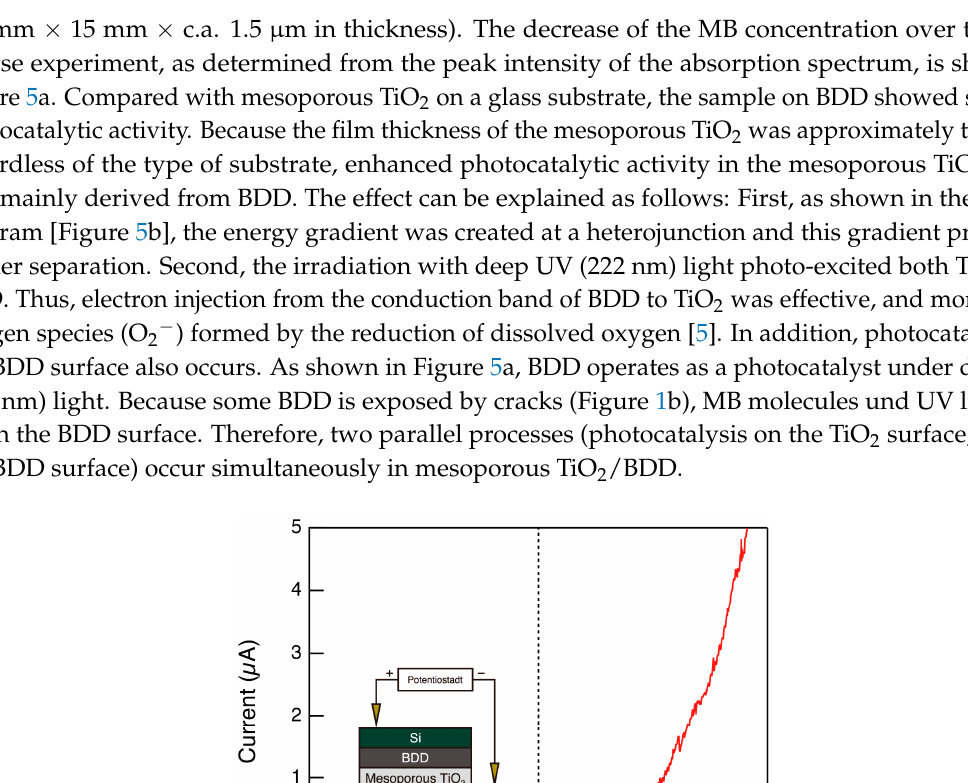
Figure 3. I–V characteristics of mesoporous TiO 2 /BDD heterojunction. Inset shows the schematic illustration of the experimental setup.